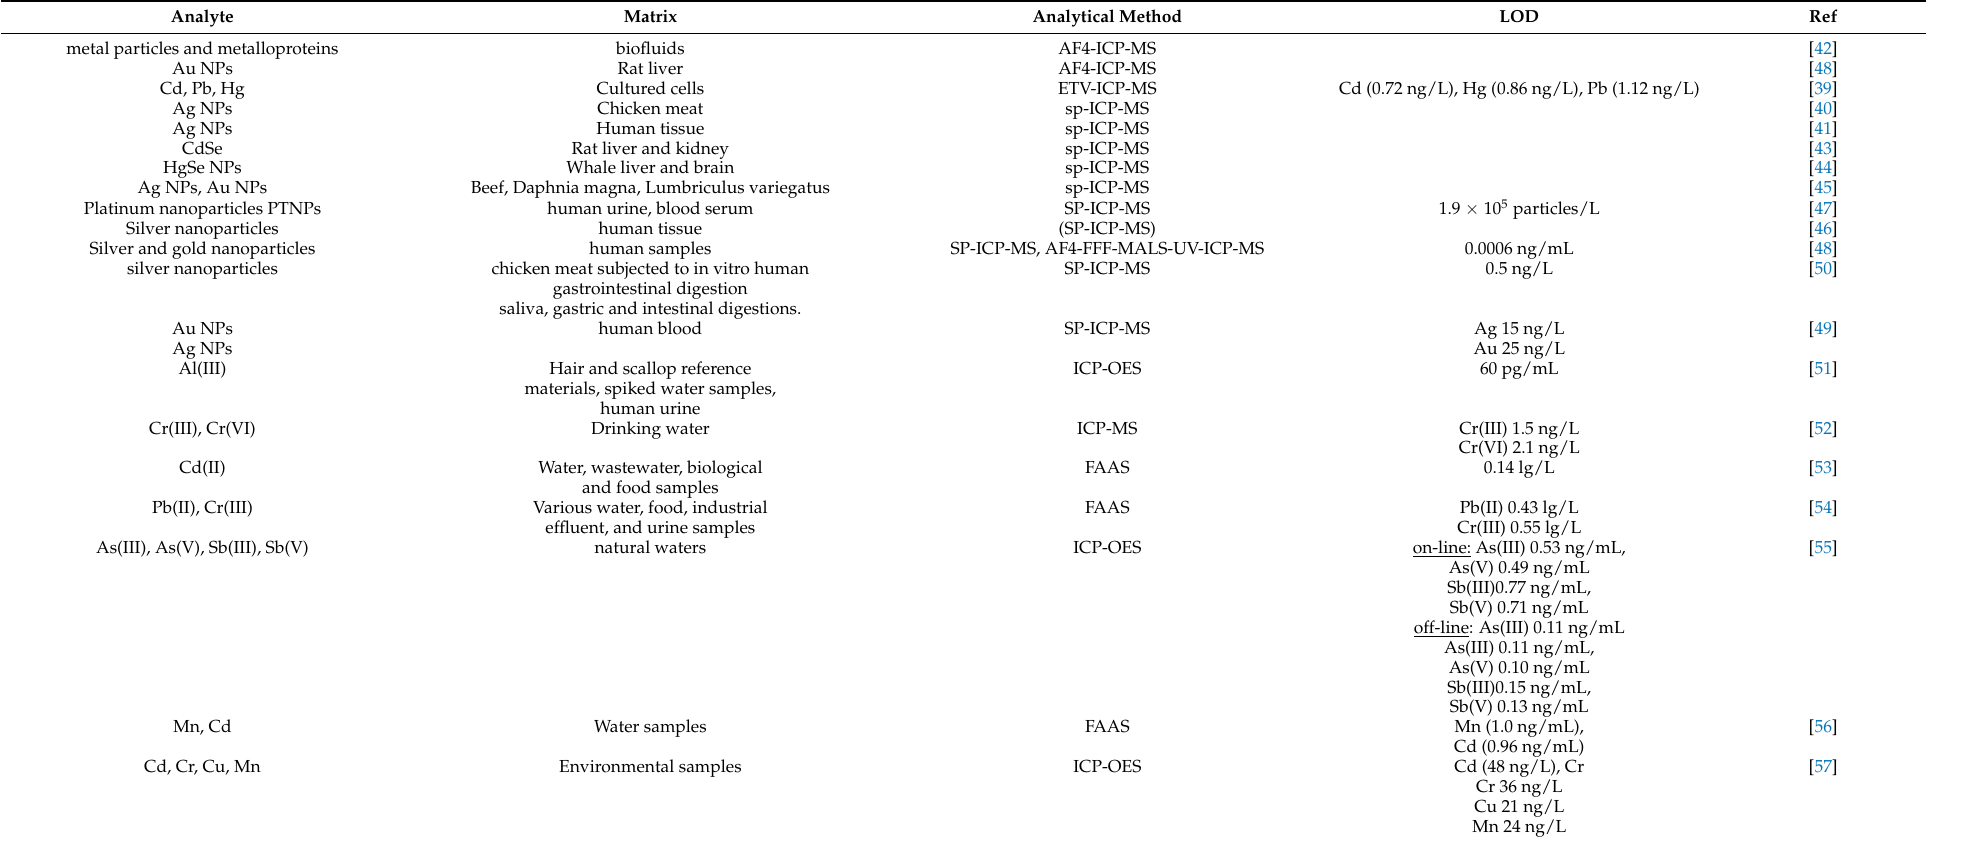
Table 1. List of analytical methods used for nanomaterial determination/characterization in biological